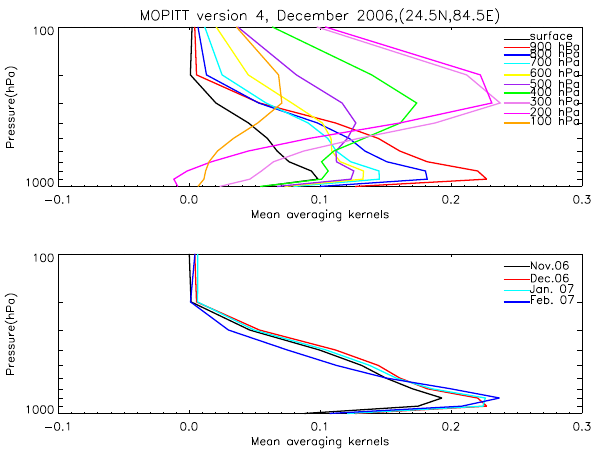
Fig. 3. (a) (top) Monthly mean averaging kernels from version 4 MOPITT data at 24.5 ◦ N, 84.5 ◦ E for December 2006 and (b) (bot- tom) Monthly mean averaging kernels at 900hPa for November 2006 through February 2007 at the same location.